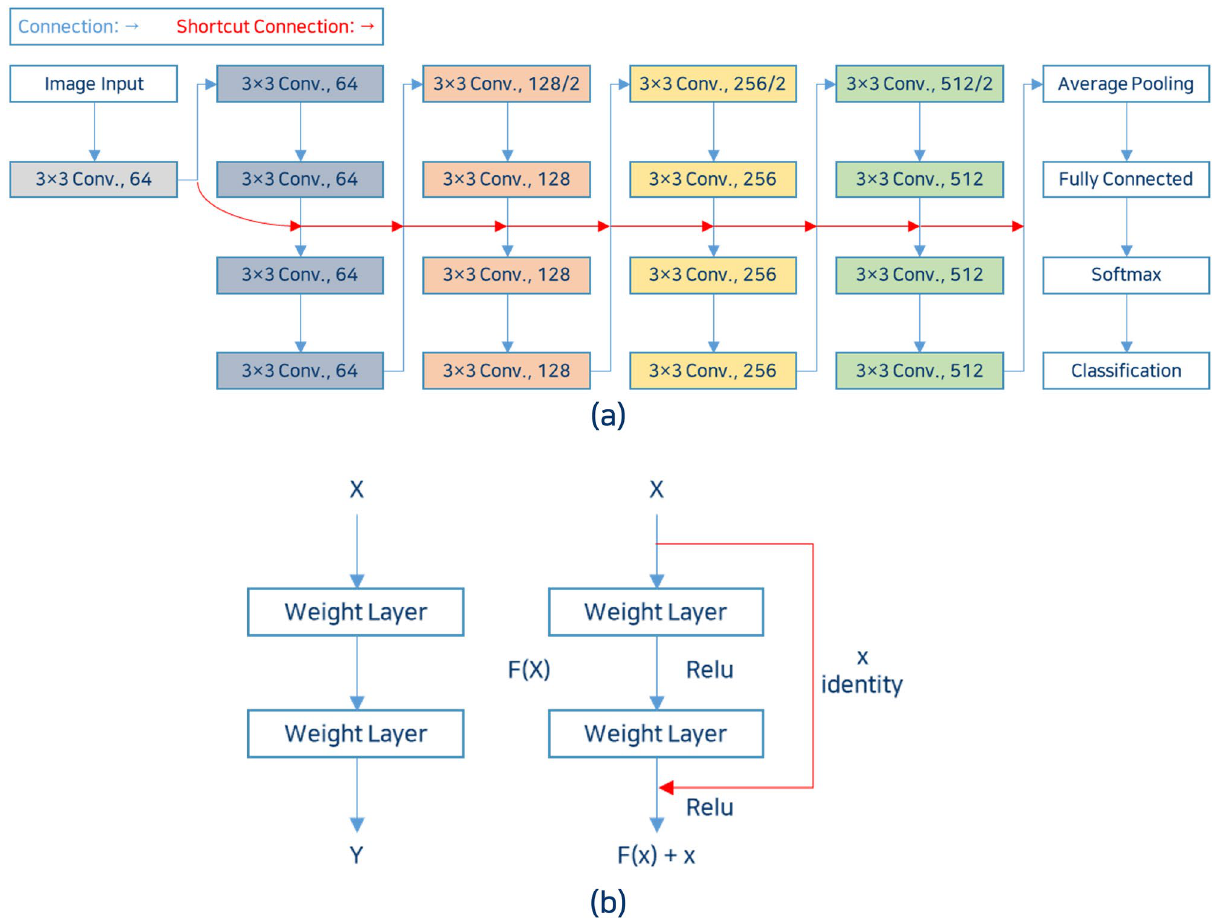
Figure 2. ResNet architecture ( a ) Neural network structure of ResNet-18 ( b ) Residual learning: building